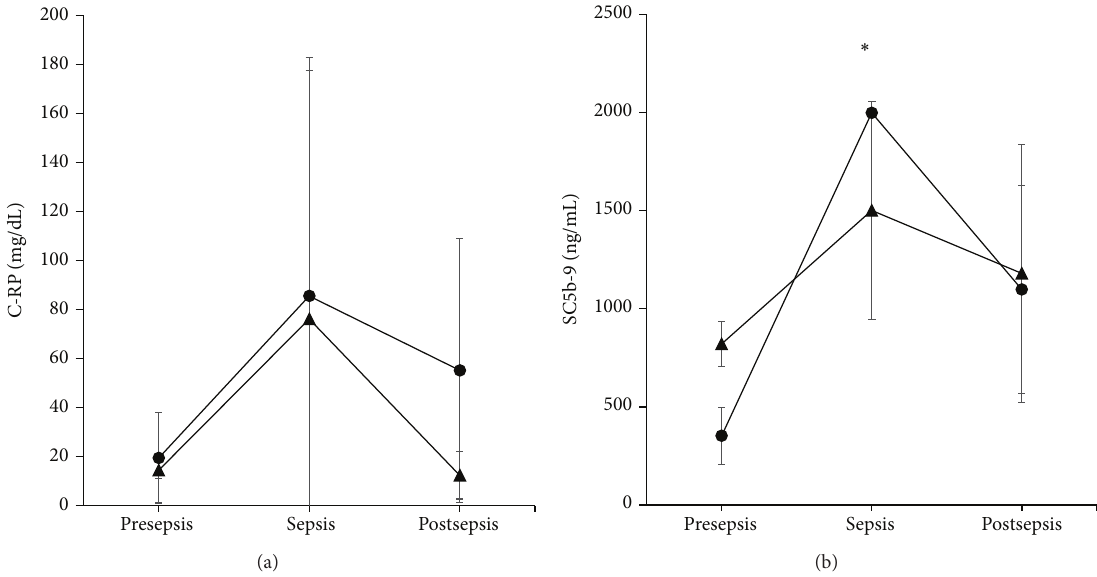
Figure 2: Innate immunity. C-RP (a) and active complement in the form of complex SC5b-9 (b) were both elevated at sepsis (mean ± standard deviation) in the PT (circle) or VPT (triangle) groups compared with presepsis and postsepsis. However, only PT neonates group was different for SC5b-9 ( ∗ 𝑃 < 0.01 ,